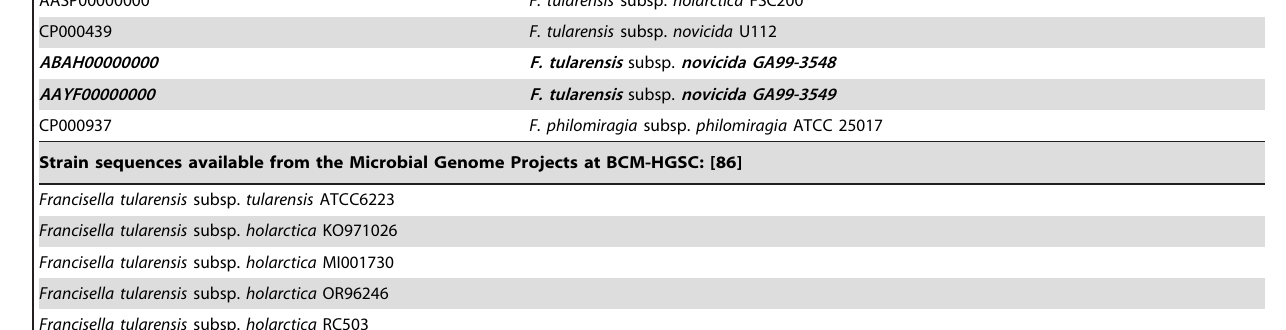
GenBank accession numbers Strain name (strains sequenced by the Broad in